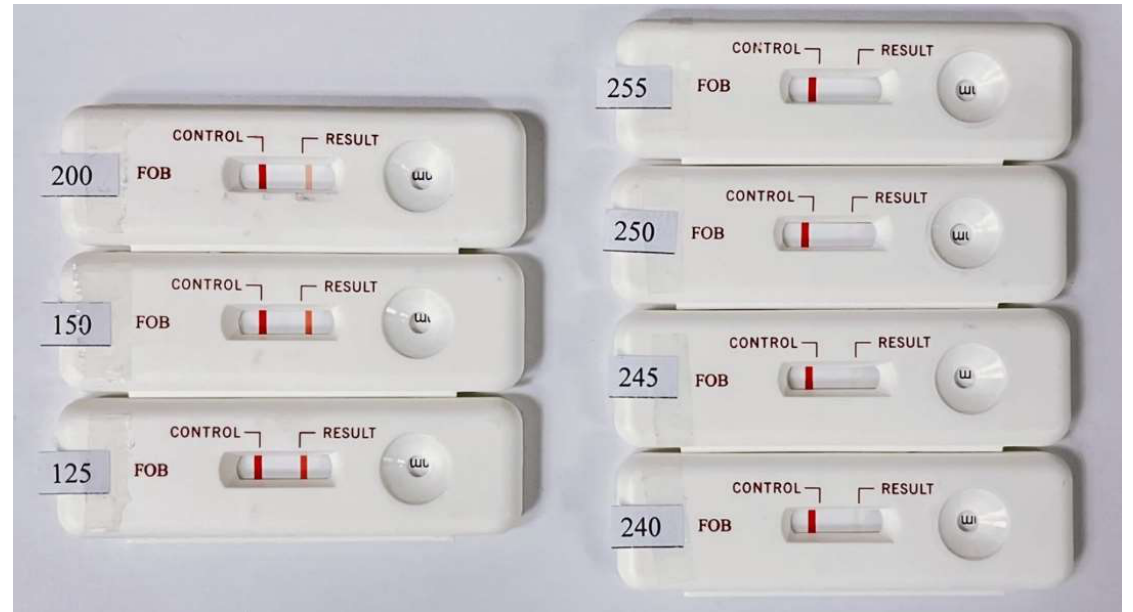
Figure 6. Designed self-made simulated rapid test strips with different grayscale values ranging from 125 to 255 for the T line.